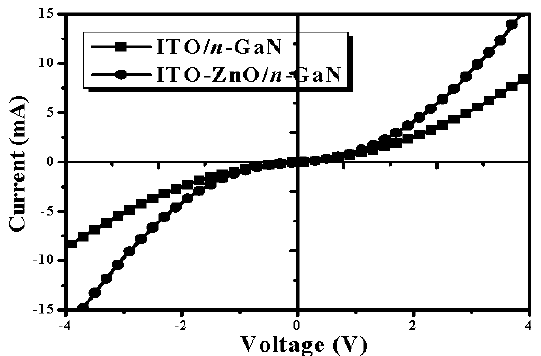
Figure 2. I ‐ V curves of the as ‐ deposited ITO and cosputtered ITO ‐ ZnO films’ contact to n ‐ GaN epilayer, respectively, measured from the contact spacing of 15 μ m.